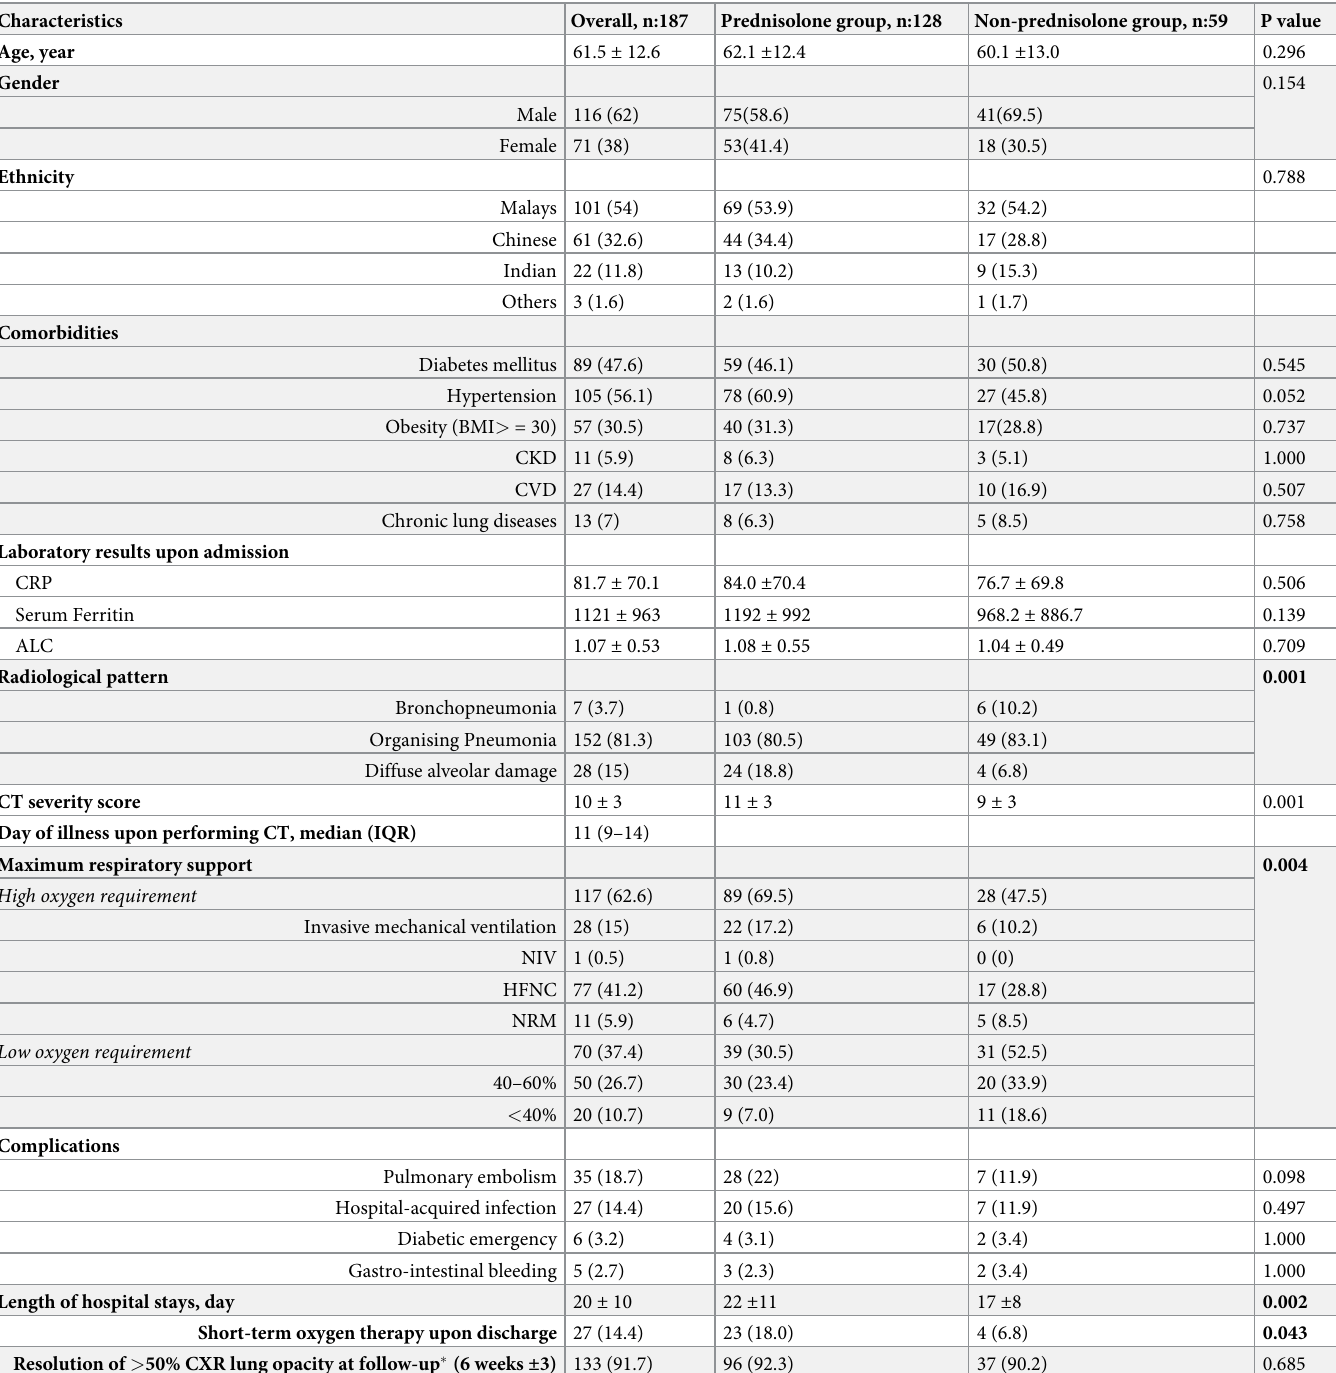
Table 1. Sociodemographic and clinical characteristics and outcome of severe COVID-19 patients with persistent respiratory failure.